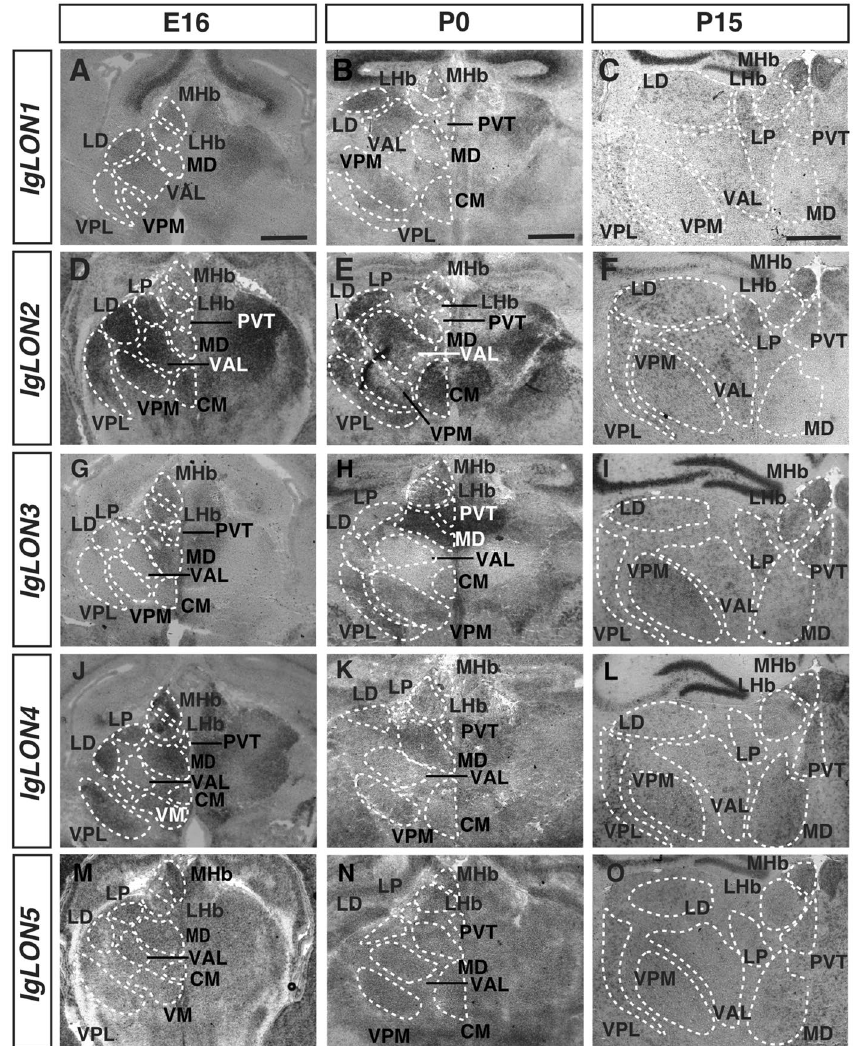
Figure 5. IgLONs mRNA expression in the developing thalamus. In situ hybridization of coronal sections of the thalamus from E16, P0, and 15 mice with antisense cRNA probes for IgLON transcripts. IgLON1 mRNA was detected in the medial habenula (MHb), laterodorsal thalamic nucleus (LD), and ventral anterolateral thalamic nucleus (VAL) at all ages examined. IgLON1 mRNA was also detected in additional nuclei, such as the ventral posteromedial thalamic nucleus (VPM) and ventral posterolateral thalamic nucleus (VPL) at P0 and P15, respectively ( A – C ). IgLON2 showed expression in the lateral habenula (LHb), the lateroposterior thalamic nucleus (LP), LD, VAL, VPM, VPL, and the mediodorsal thalamic nucleus (MD) at all ages analyzed ( D – F ). At E16 and P0, IgLON2 could also be detected in the centromedial thalamic nucleus (CM), and expression in the PVT was observed at P15 ( D – F ). IgLON3 was detected in the MHb, LHb, PVT, and MD ( G – I ). At P15, expression could also be detected in the LD, VPM, and VPL ( I ). At E16, IgLON4 showed expression in the LHb, MHb, PVT, LP, LD, MD, CM, VPL, and the ventromedial thalamic nucleus (VM) ( J ). IgLON4 was also observed in the majority of these nuclei at P0 and P15 ( K , L ). IgLON5 mRNA expression was visible in the MHb at all ages analyzed. Low levels of expression were also detected in most thalamic nuclei. ( M – O ). All scale bars = 500